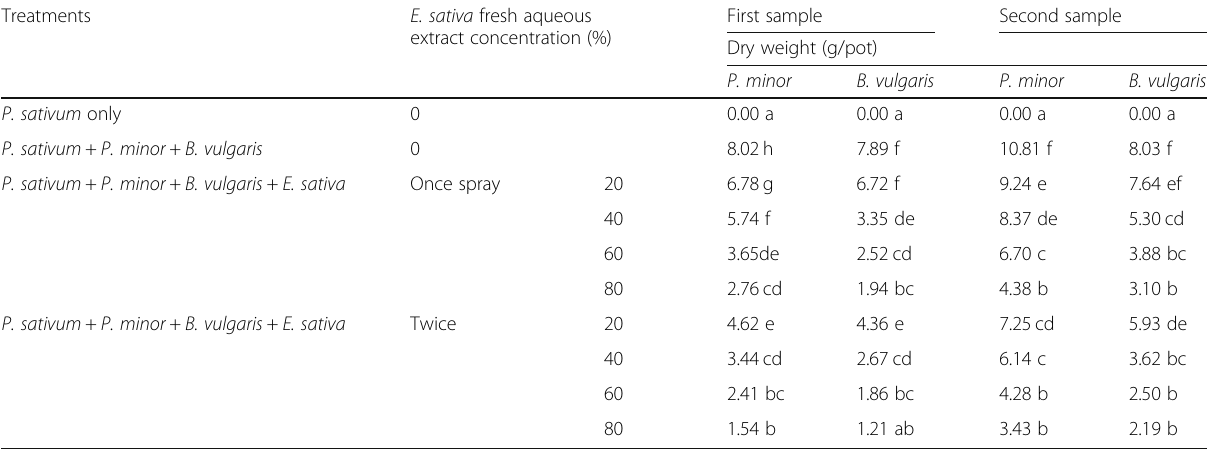
Table 2 Effect of spraying different concentrations of E. sativa fresh aqueous extract on dry weight of P. minor and B. vulgaris (g/ pot). (Combined analysis of the two seasons) Treatments